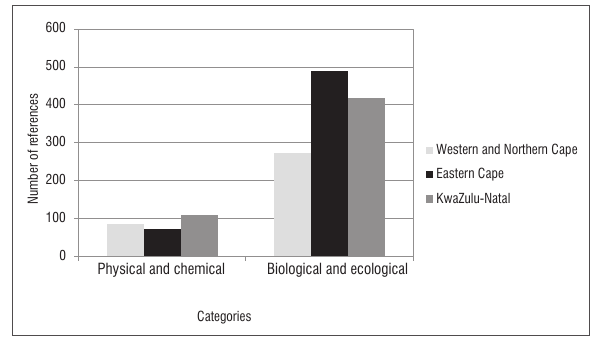
Diagram illustrating the number of estuarine-related references in two categories from three major regions along the South African